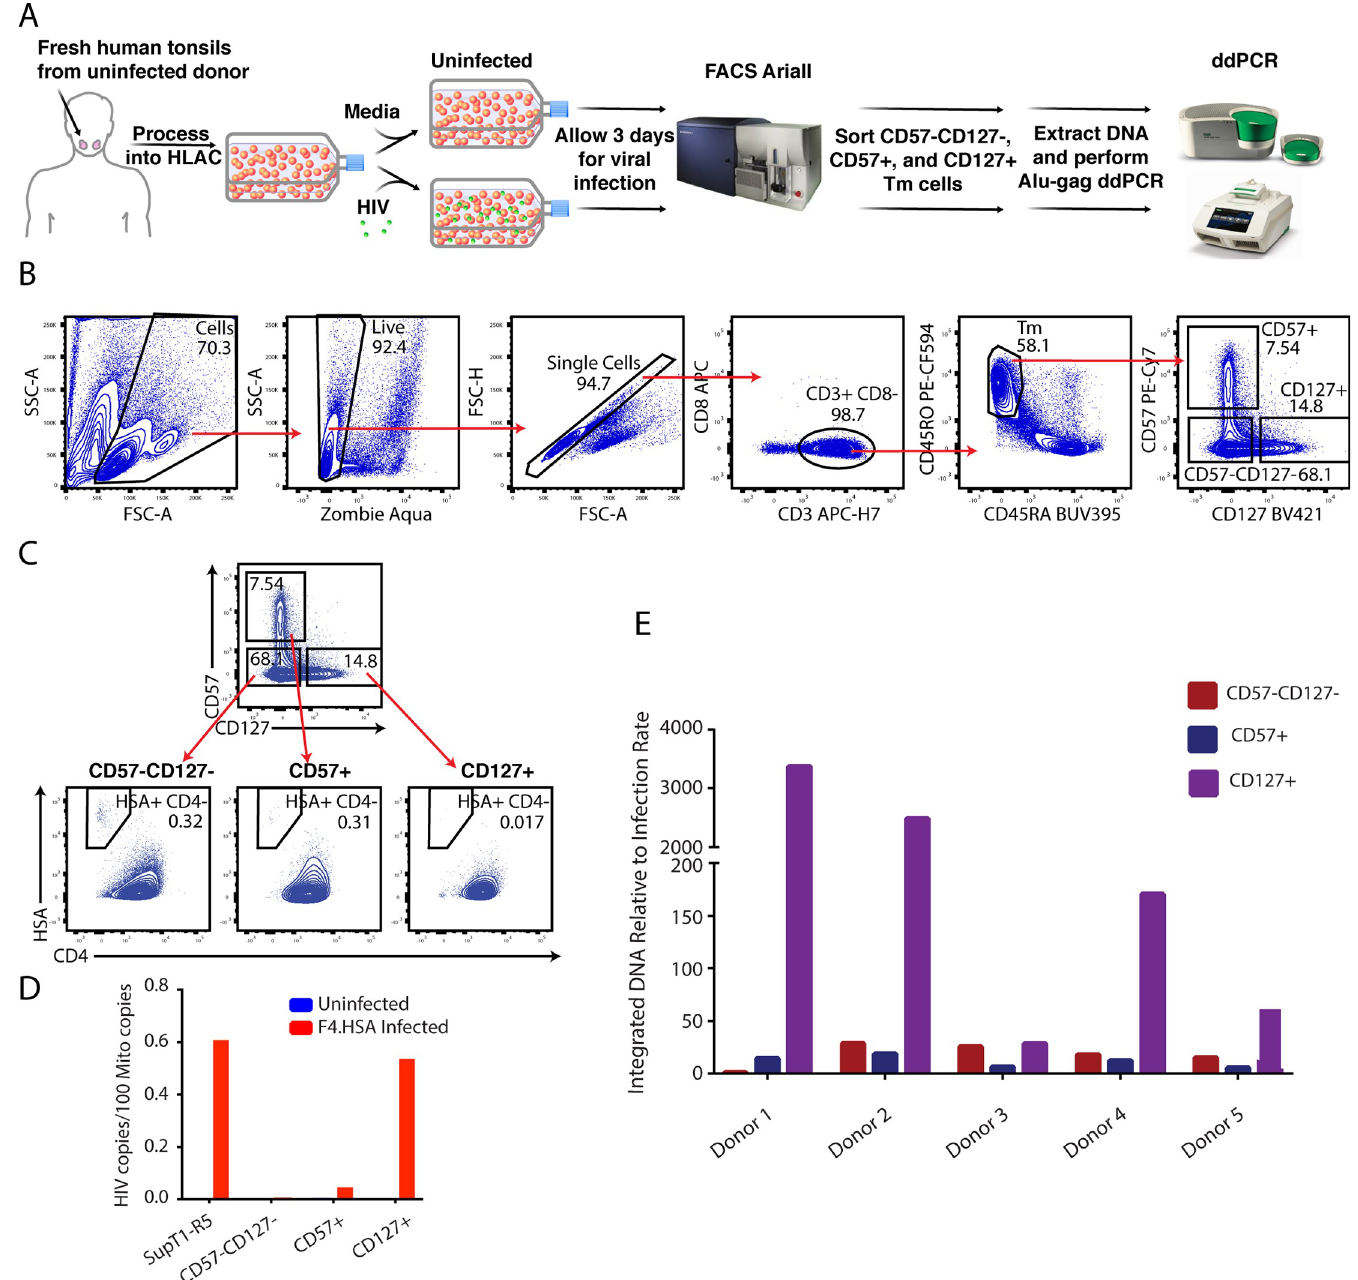
Fig 3. CD127+ Tm cells preferentially support latent infection by HIV-1. A) Schematic of experimental design for quantitating integrated HIV DNA in memory CD4 + T cell subsets from HIV-exposed HLACs. HLACs were mock-treated or infected with F4.HSA and cultured for 3 days. Cells were then sorted using an AriaII instrument for the CD57-CD127-, CD57+, and CD127+ Tm populations. Genomic DNA was extracted from sorted cells, and a two-step Alu-Gag ddPCR was performed to amplify and quantitate HIV DNA from these samples. A second ddPCR reaction designed to detect mitochondrial DNA was performed in parallel for all samples to quantify DNA input, and was used for normalization. B) Gating strategy for sorting of HLAC cultures. Live, singlet CD3+CD8- cells (corresponding to CD4 + T cells) were further gated on memory cells (CD45RO+CD45RA-), and then divided into populations of CD57+, CD127+, and CD57-CD127- Tm cells as shown. These sorted populations were used to quantitate the levels of integrated HIV DNA. C) Flow cytometric plots showing the sorted populations of memory CD4+ T cells from F4.HSA-exposed HLACs, demonstrating the expected low infection rates in the CD127+ Tm cells as compared to the other two Tm subsets. D) The samples shown in panel C were subjected to ddPCR to quantitate the levels of integrated HIV DNA. Infected SupT1-R5 served as a control. Results were normalized to the amount of mitochondrial DNA in each sample. No integrated HIV DNA was detected in uninfected cells subjected to the same protocol. E) The protocol schematized in panel A was conducted on 5 independent donors. The levels of integrated HIV DNA in each population (normalized to mitochondrial content) were divided by the rate of productive infection (as defined by the frequency of HSA+CD4- cells) to demonstrate that the CD127+ Tm cells always harbored a disproportionately high level of HIV DNA relative to their productive infection rate.